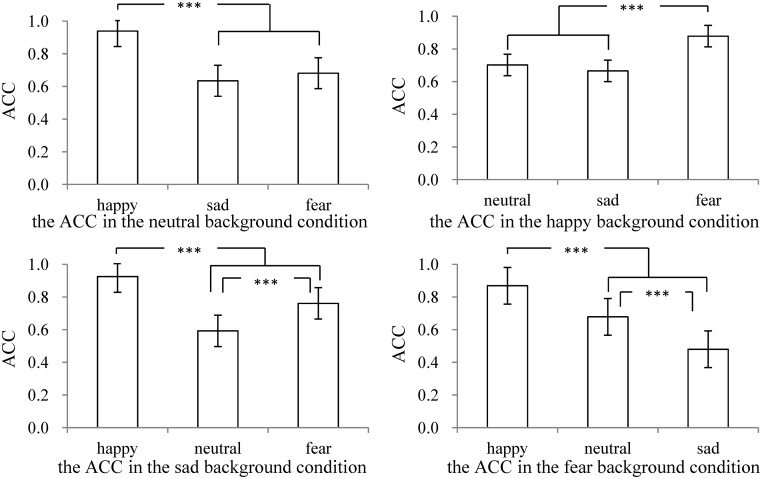
The ACC of recognizing different MEs in different background conditions.“***”stands for “p< 0.001”. Error bar represents standard errors.